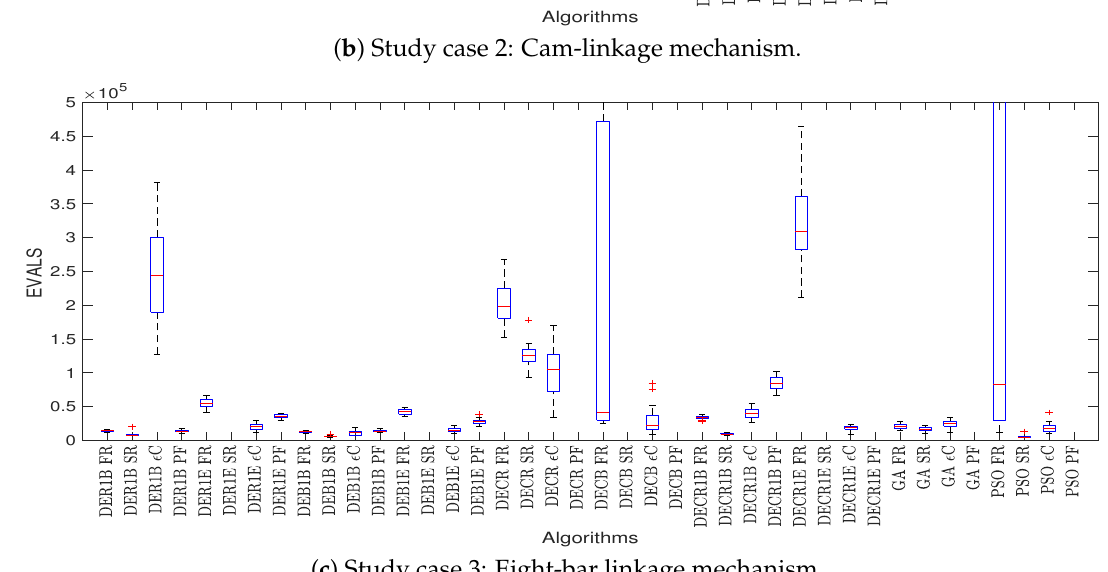
Figure 6. Box plot of the sample distribution obtained by EVALS in ten metaheuristics at each study case of mechanism synthesis for lower limb